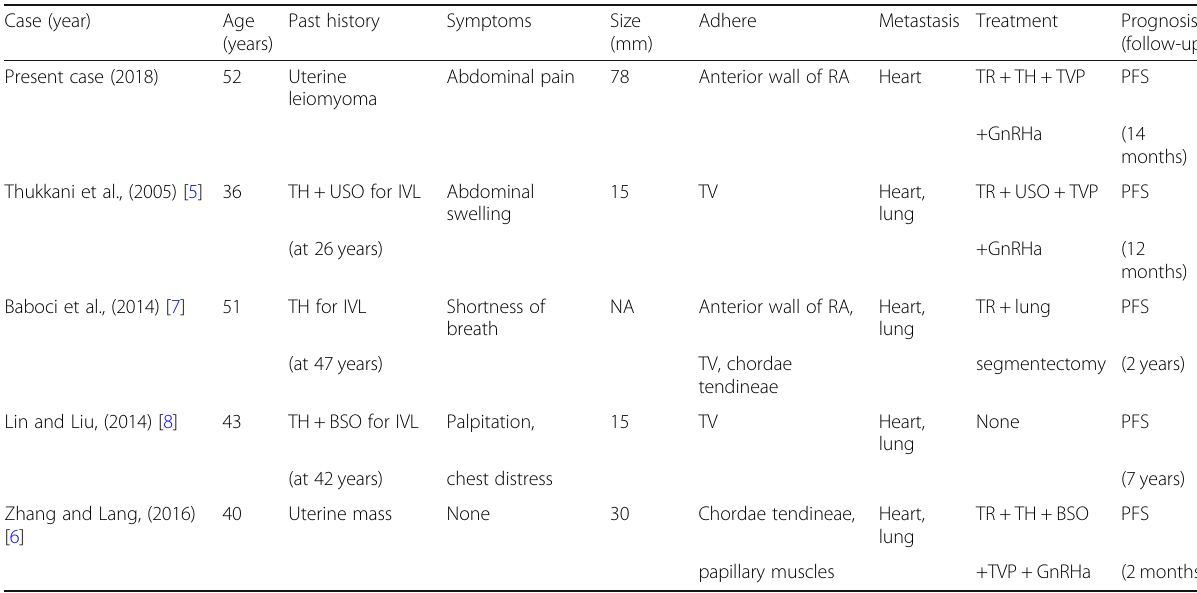
RA Right atrium, TR Tumor resection, TH Total hysterectomy, TVP Tricuspid valvuloplasty; GnRHa Gonadotropin releasing hormone agonist, PFS Progression free survival, USO Unilateral salpingo-oophorectomy, IVL Intravenous leiomyomatosis, TV Tricuspid valve, NA Not available, BSO Bilateral